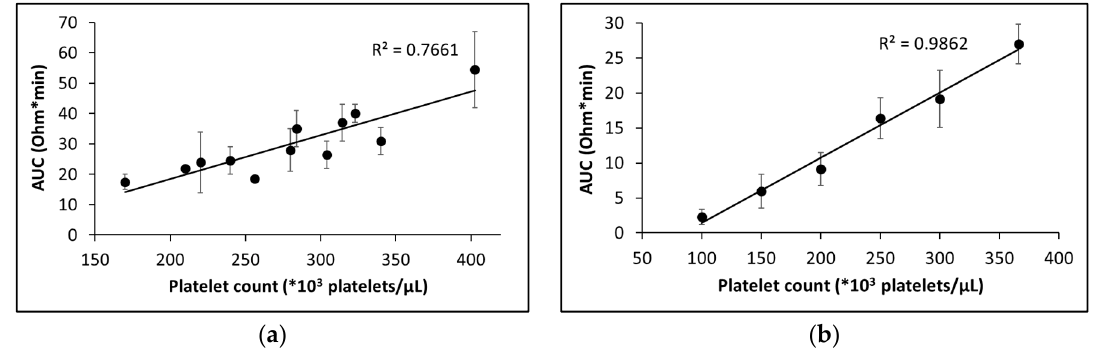
Figure 6. The extent of platelet aggregation linearly corelates with platelet count in hirudin- anticoagulated whole blood ( a ) and platelet-rich plasma ( b ): AUC—area under the curve. In whole blood, the actual platelet count was not adjusted. In PRP, platelet count was manually adjusted by adding platelet-poor plasma. Then, platelet aggregation was induced by 20 μ M ADP. Data from 12 ( a ) or 6 ( b ) independent experiments using blood samples from different donors are reported. Mean ± SD as error bars of AUC are indicated.